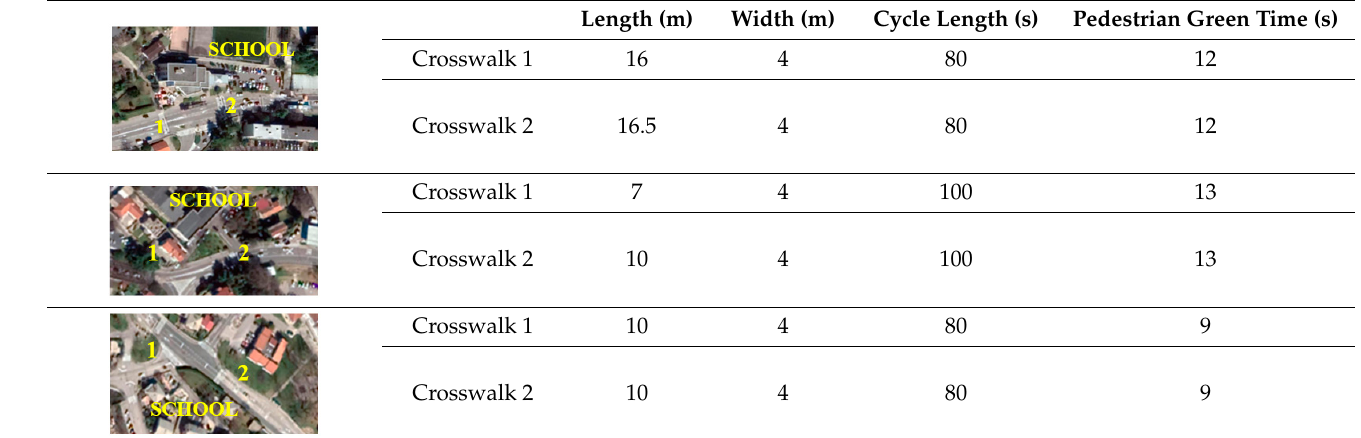
Table 3. Basic characteristics and positions of crosswalks in Rijeka, Croatia.